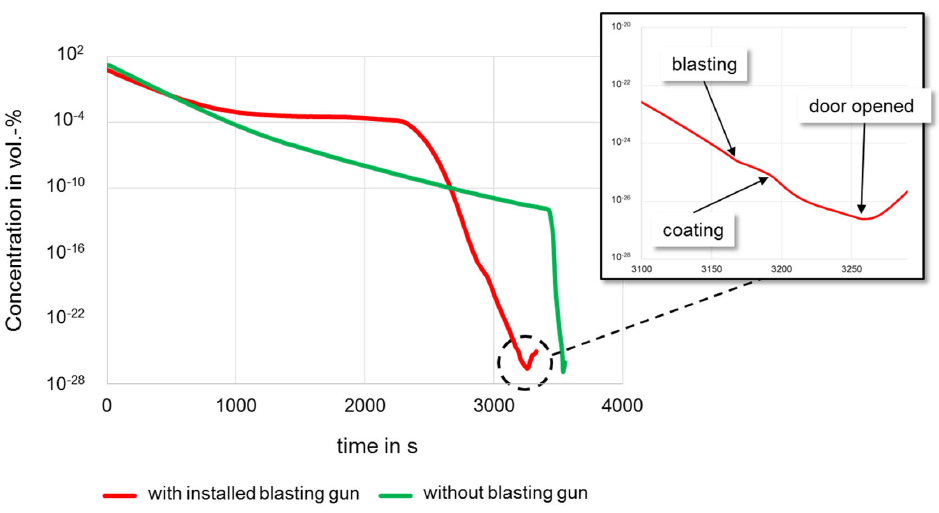
Figure 2. Evolution of the oxygen concentration as monitored with a lambda probe during flushing, blasting, and the actual coating process.